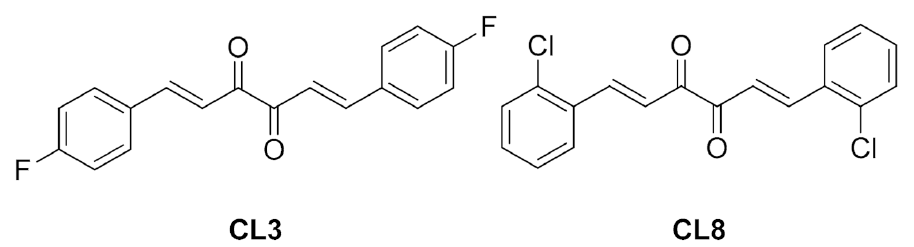
Figure 5. Structures of curcumin-like (CL)